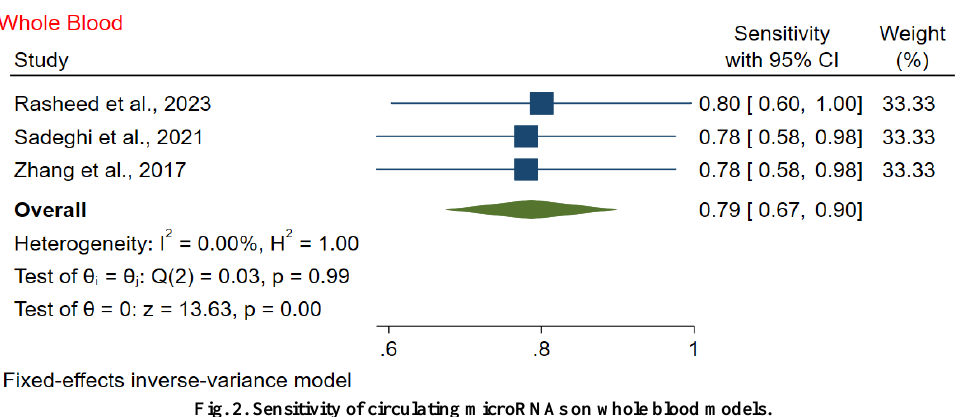
Fig. 2. Sensitivity of circulating microRNAs on whole blood models.